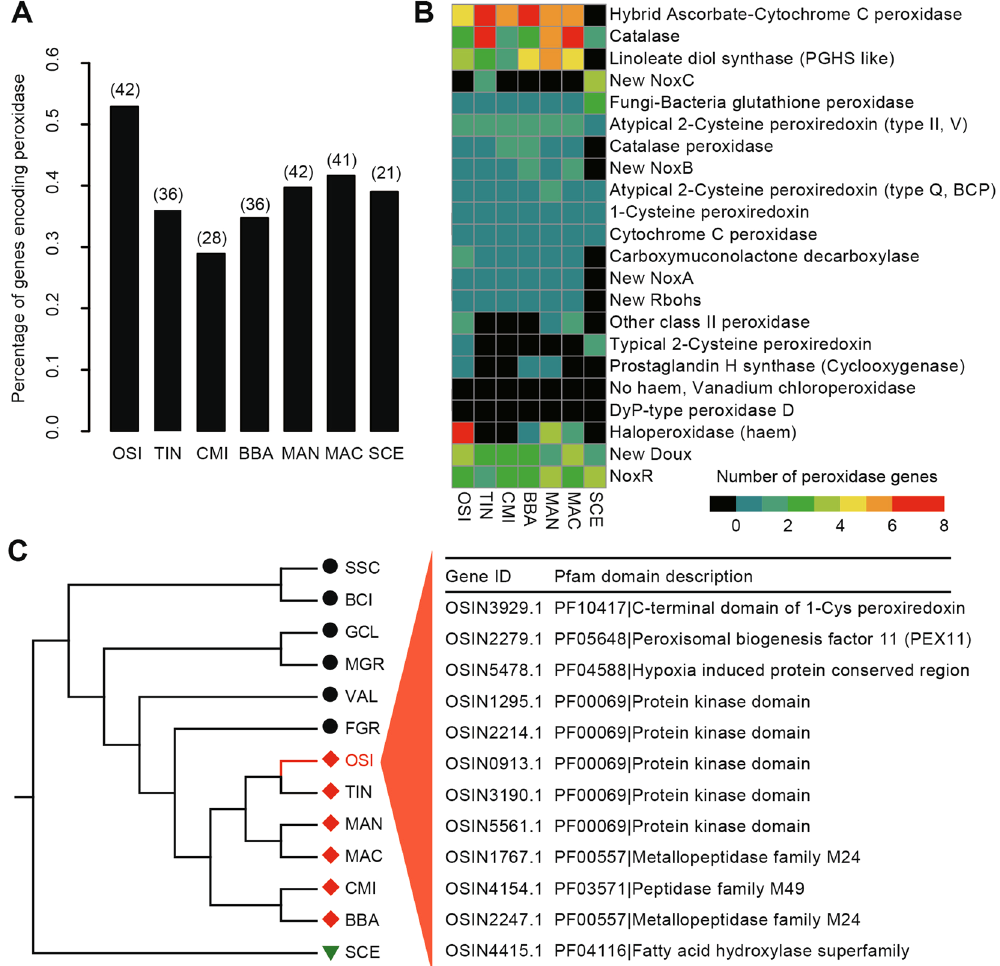
Figure 3. Analysis of peroxidase genes and positive selection. ( A ) Comparisons of the percent and number (parentheses) of peroxidase genes among the five entomopathogenic fungi and yeast ( S . cerevisiae ). Abbreviations: TIN, T . inflatum ; SCE, S . cerevisiae . ( B ) Peroxidase gene subtypes are defined by fPoxDB (http://peroxidase.riceblast.snu.ac.kr). The number of genes within each peroxidase class are presented using “ pheatmap ” package implemented in R program (version 3.0.1). ( C ) Positively selected genes (PSGs) detected in O . sinensis lineage. 12 PSGs potentially associated with high-altitude adaptation and host infection are shown (right panel). Phylogenic relationships among 13 fungal species (left panel). Plant pathogens are labeled with black solid circles, whereas insect pathogens are colored in red diamonds. S . cerevisiae was selected as outgroup and depicted in a green